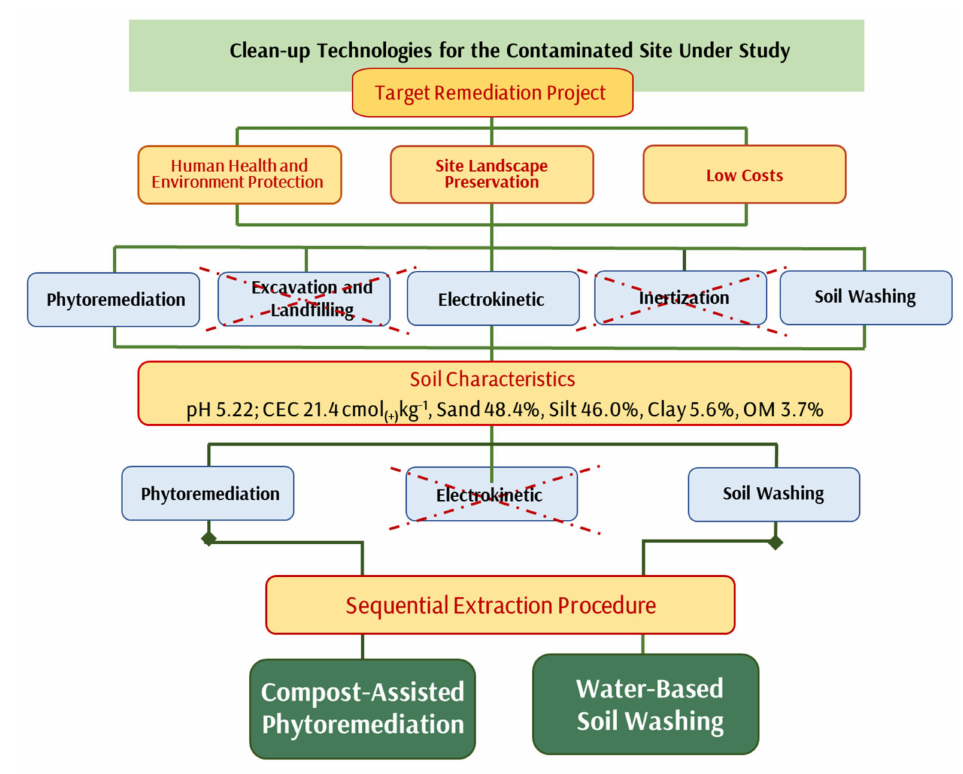
Figure 1. Scheme of technologies screening based on soil properties of the contaminated